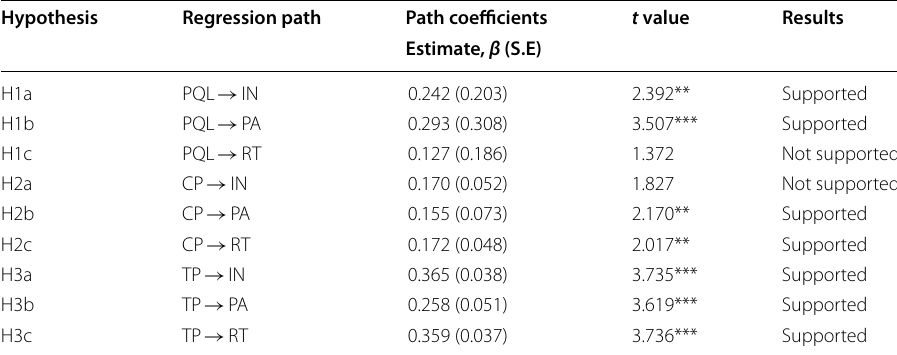
Table 5 Influence of market information needs on entrepreneurial